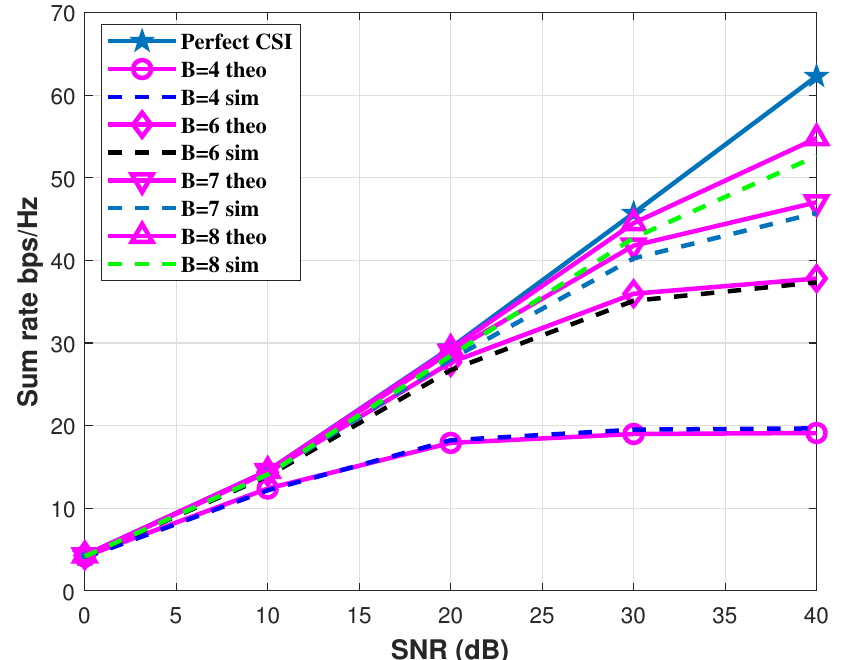
Figure 9. Performance comparison of theoretical and simulation results with SQ-based CSI feedback with different quantization bits in ( 3 × 3,1 )